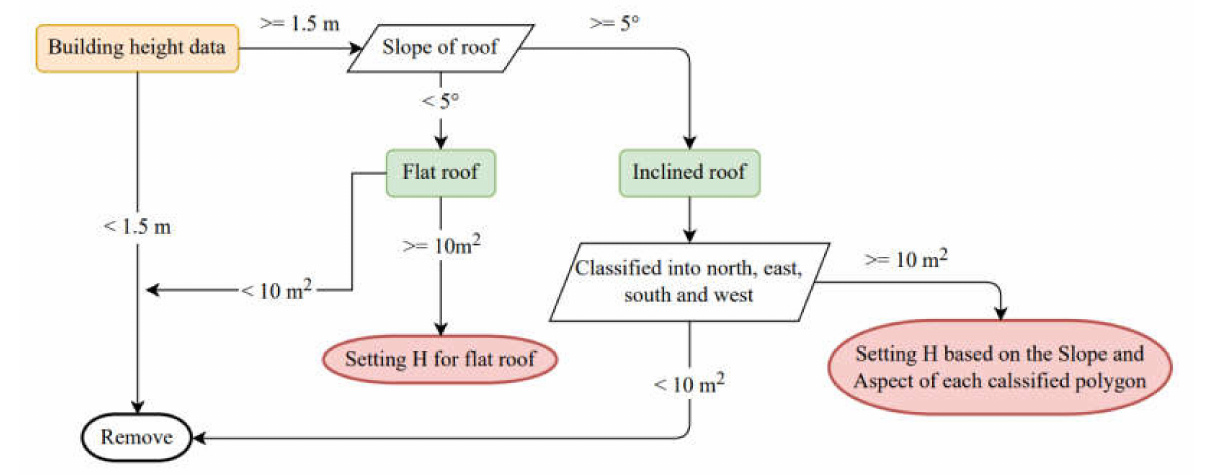
Figure 4. Flow of the analysis of building height and roof